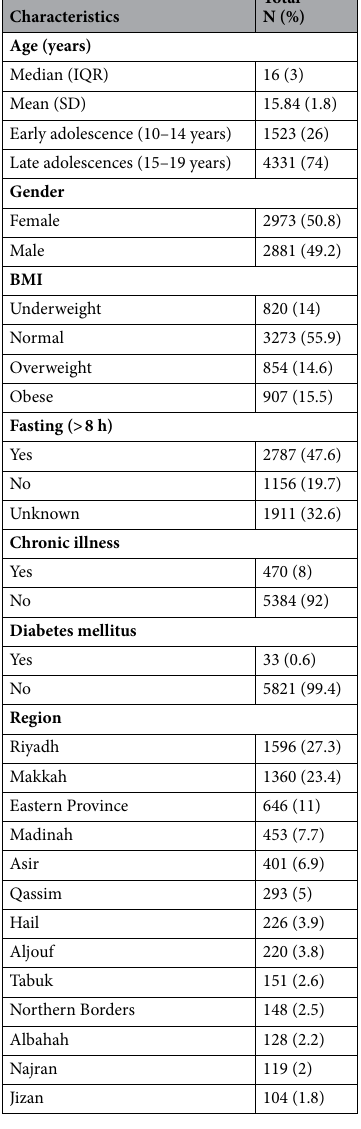
Table 1. General characteristics of the study participants. % percentage, BMI , body mass index, hr hour, N number of participants.